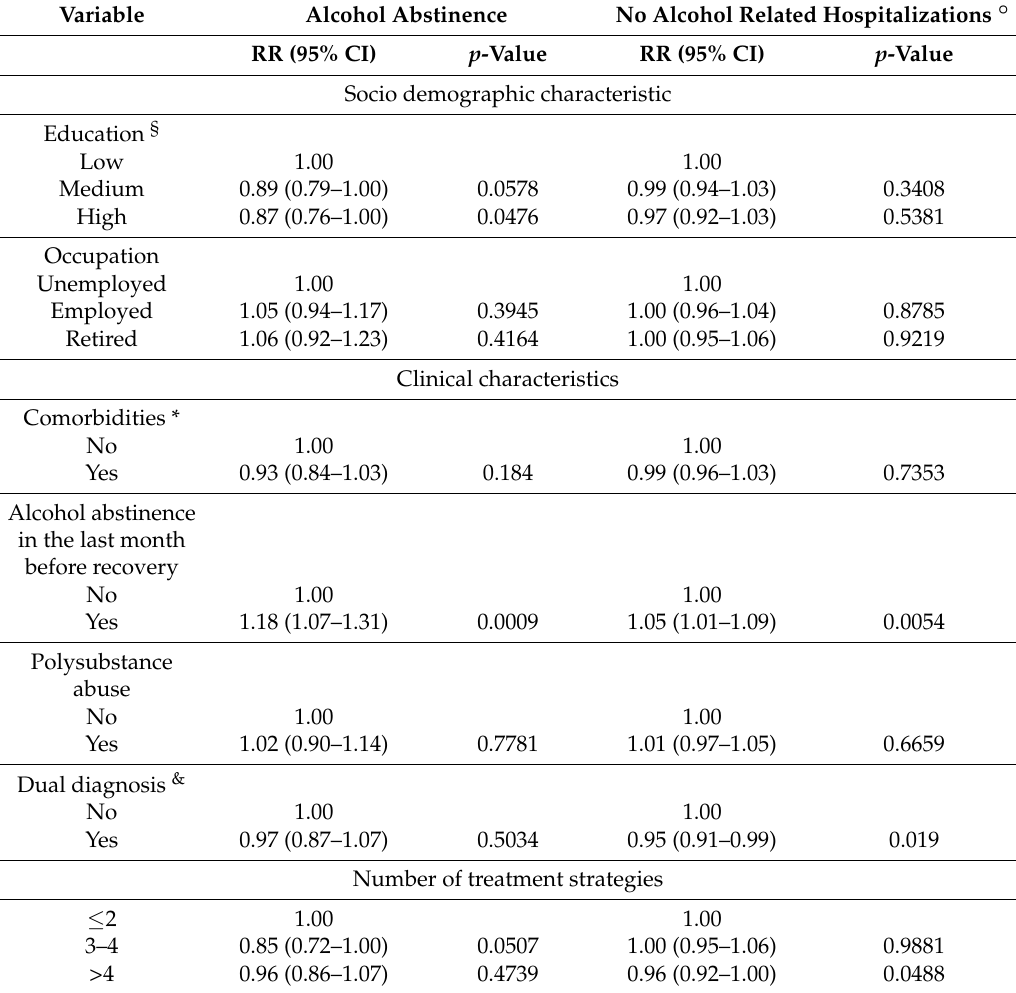
Table 2. Associations between sociodemographic characteristics, clinical characteristics, and the number of treatment strategies and alcohol abstinence and no alcohol related hospitalization at six and 12 months, using a univariate